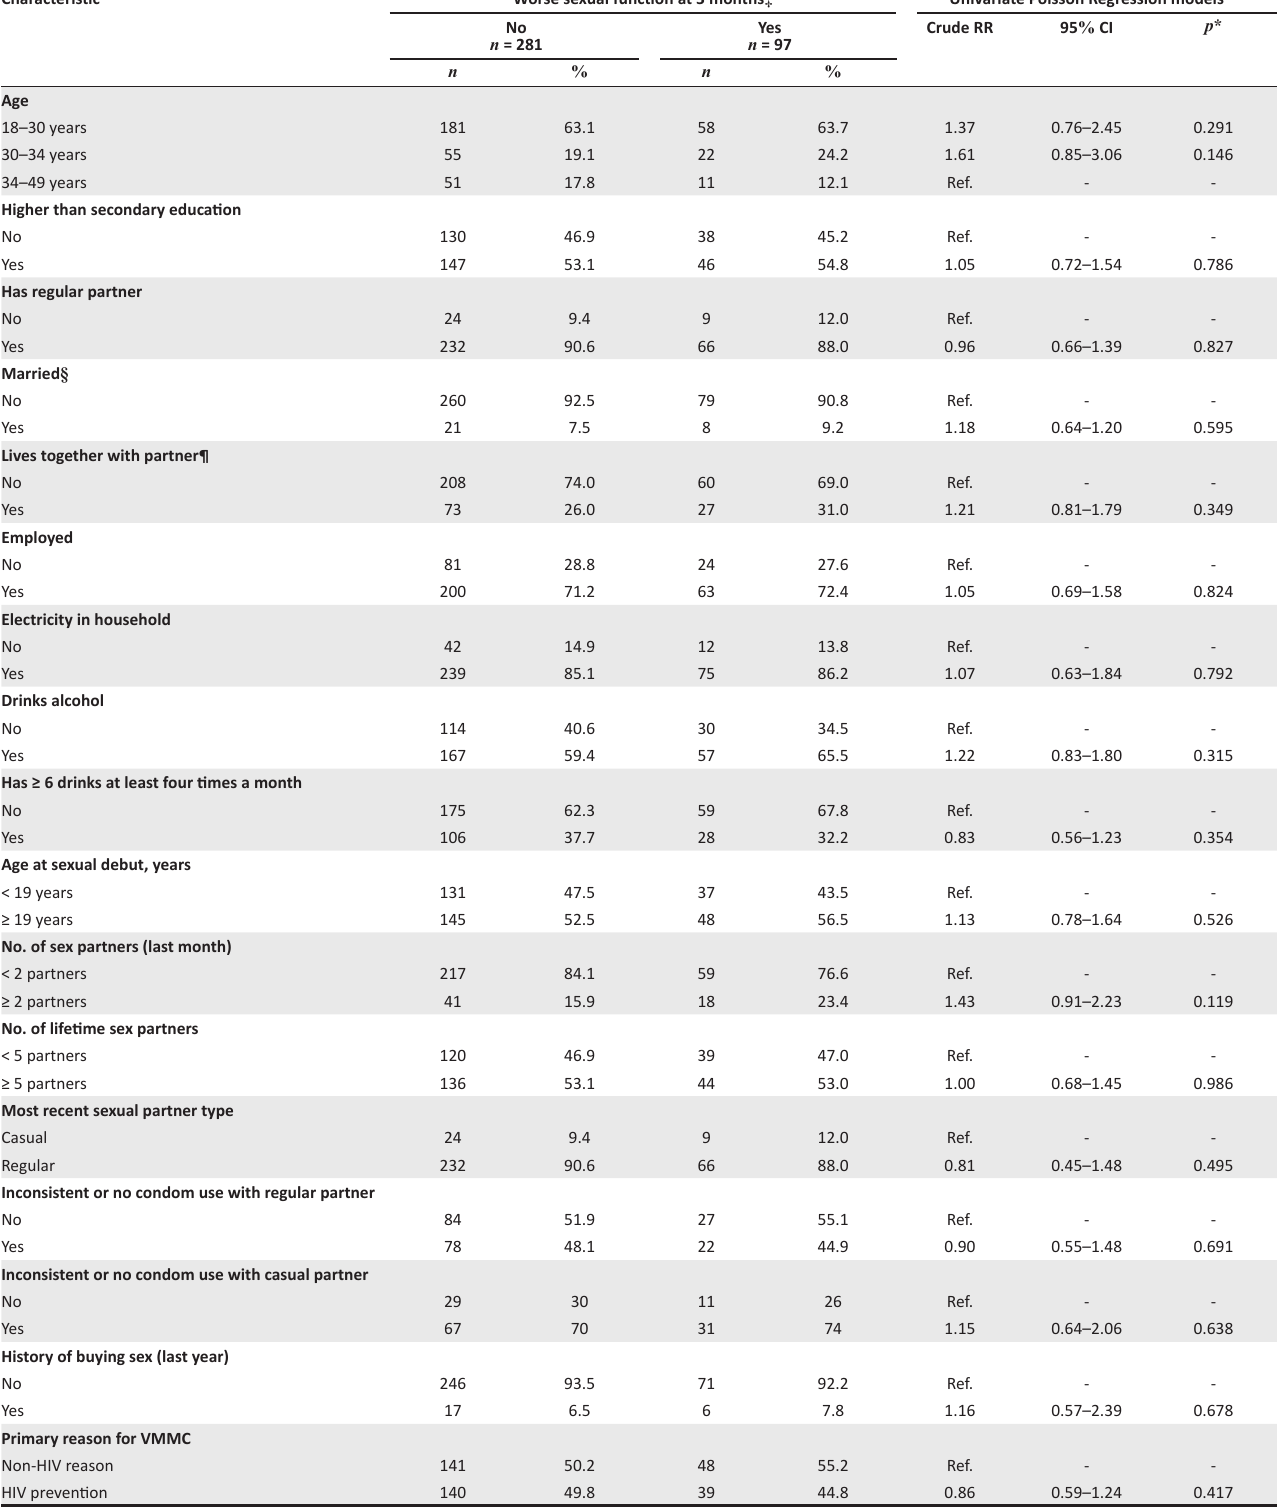
TABLE 2: Predictors of reporting worse sexual function in any category at 3 months after voluntary medical male circumcision, compared to pre-voluntary medical male circumcision amongst men uninfected by the human immunodeficiency virus who underwent voluntary medical male circumcision ( n = 378). † , ‡